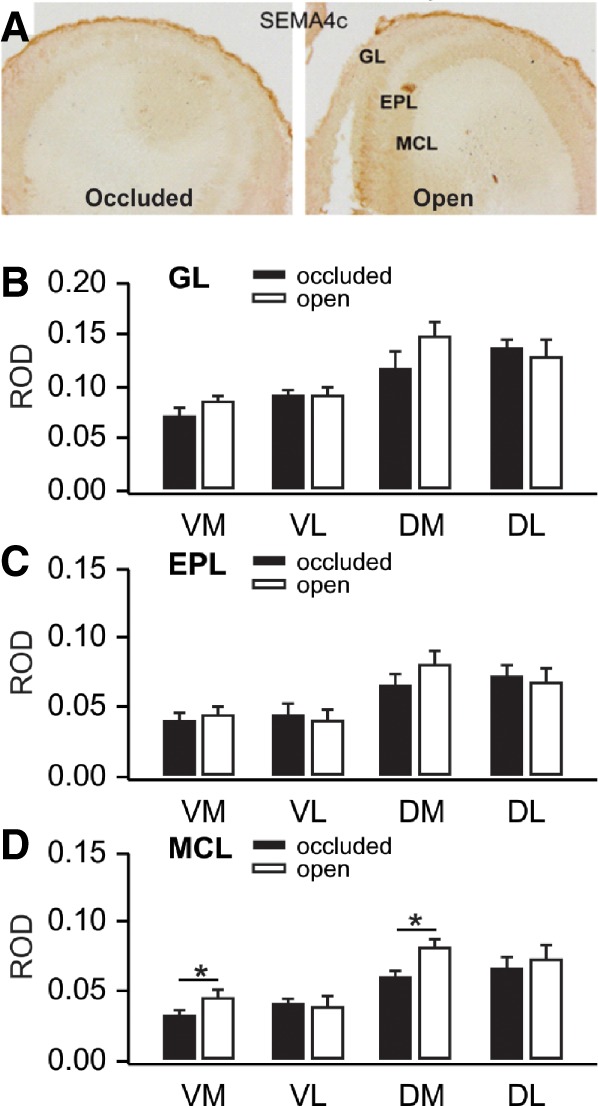
(A) Sema4c immunohistochemical staining in olfactory bulbs ipsilateral to occluded and open nares 50 min following odor + stroking training. (B) Glomerular layer ROD values for olfactory bulb quadrants receiving input from occluded and open nares. (C) External plexiform ROD values for olfactory bulb quadrants receiving input from occluded and open nares. (D) Mitral cell layer ROD values for olfactory bulb quadrants receiving input from occluded and open nares. Error bars represent SEMs. * P < 0.05, see results for exact values.